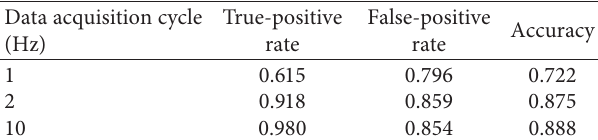
Table 6: Metric scores for algorithm (data acquisition cycle � 1, 2,